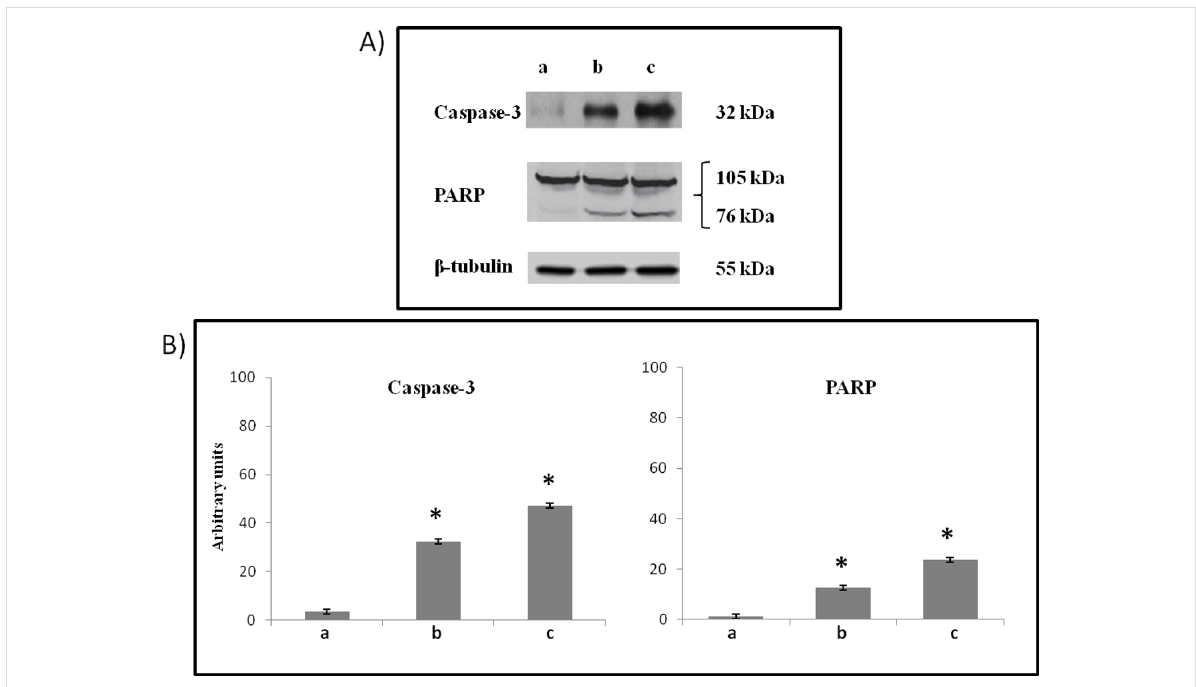
Figure 11: (A) Representative Western Blots and (B) densitometric analysis of caspase-3 and PARP cleavage in total cellular lysates of SH-SY5Y cells non-exposed (a), exposed at 72 h to 10 μ M 6e (b) or 10 μ M Nutlin-3 (c), performed after normalization with β -tubulin. Blots shown are represen- tative of Western blot analysis of four experiments in duplicate. Results are expressed as the mean ± SD of the values of four experiments in dupli- cate. *P < 0.05, significant differences vs controls.